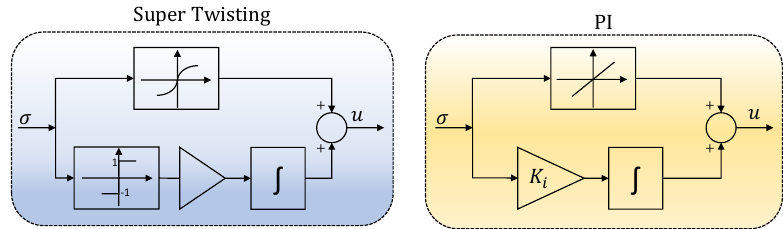
Figure 10. Comparison of PI with super twisting controller [32].